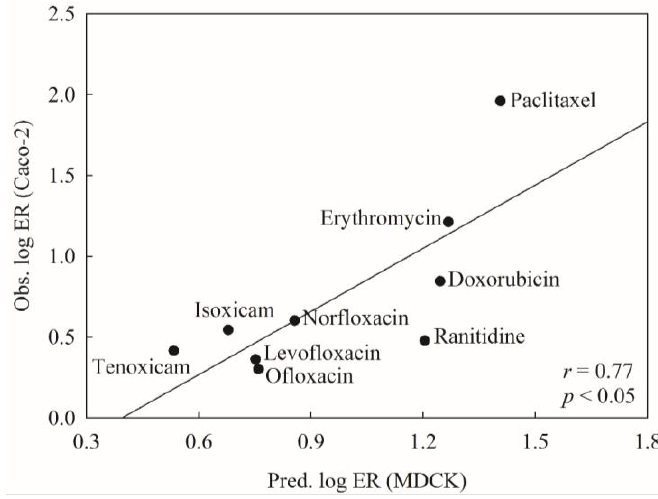
Figure 5. The observed log ER values (Caco-2) vs. the predicted log ER values